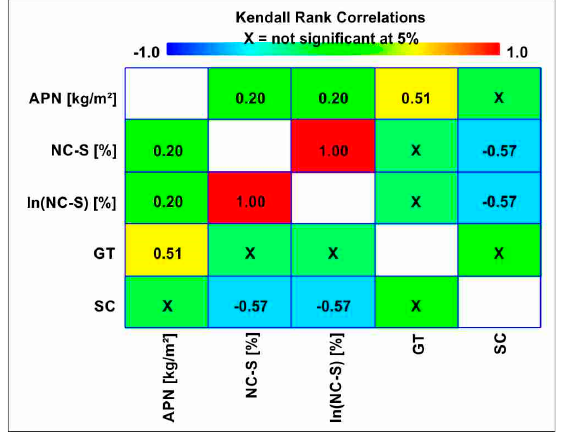
Figure 10. Kendall’s rank correlation coefficients for pairs of analyzed variables.